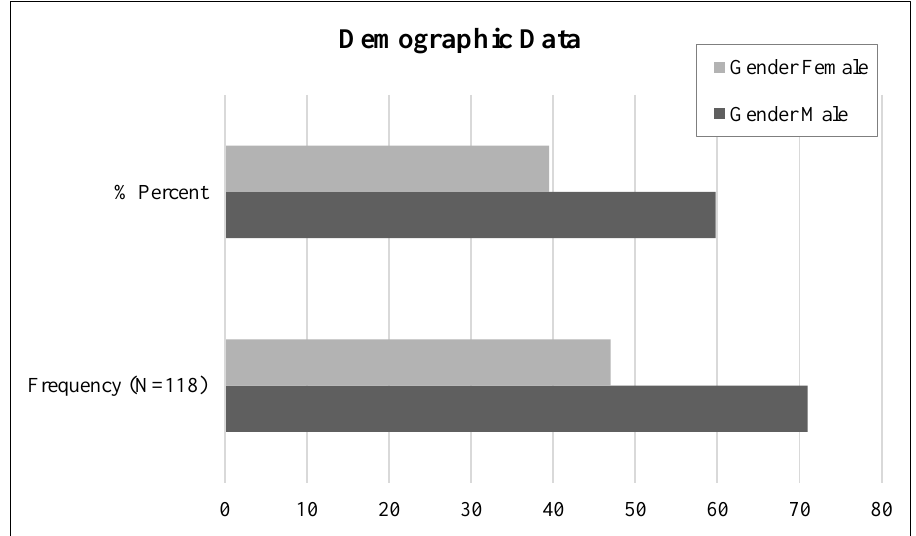
Figure 5. Gender of the